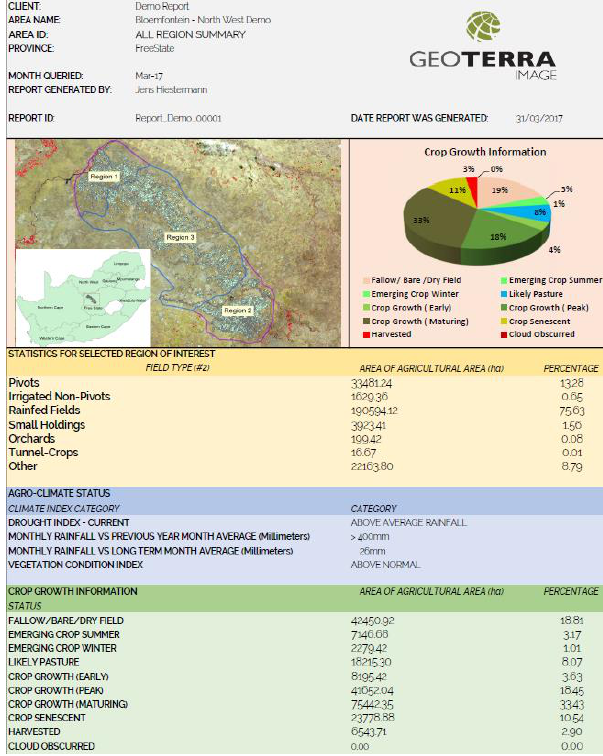
Figure 3: A sample report representing the end-user product provided in the GeoFarmer web-based